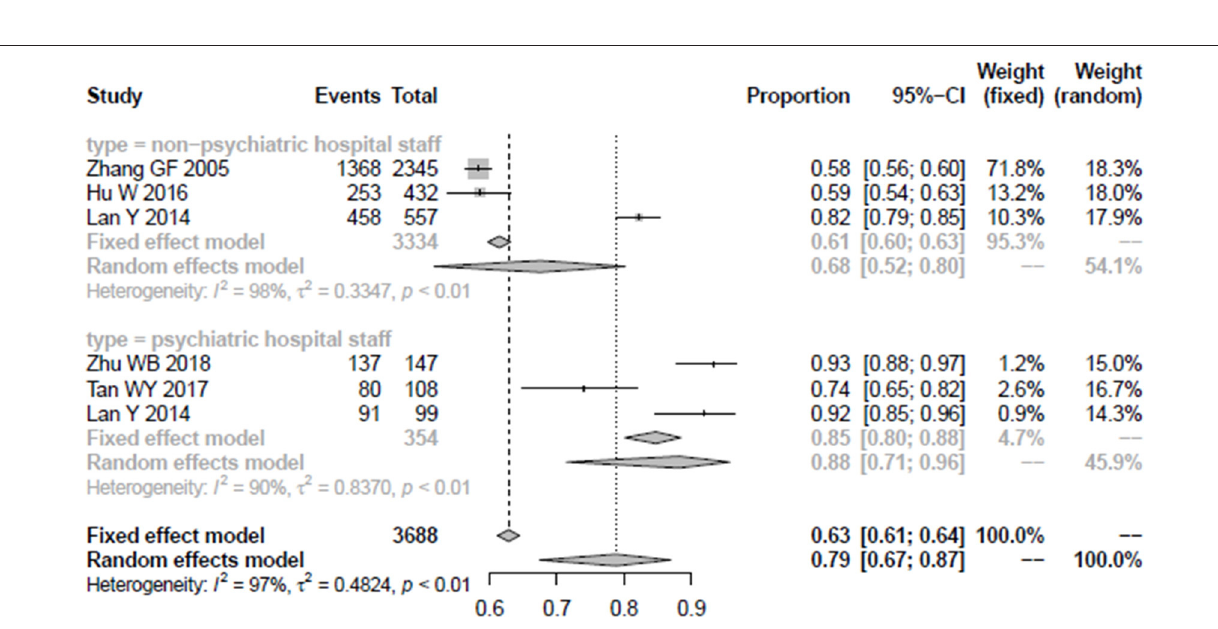
Frontiers in Psychiatry |